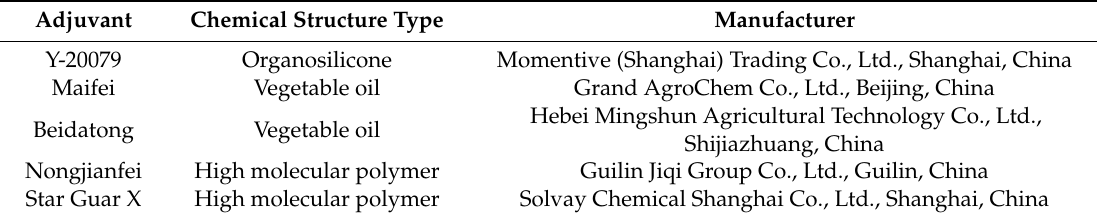
Table 1. Details of aviation spray